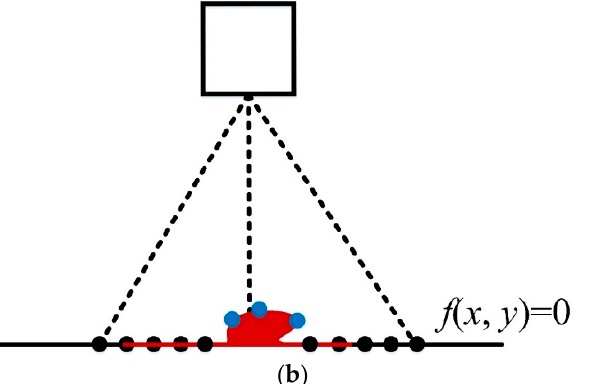
Figure 6. Automatic burr detection. ( a ) contour fitting of processed edge. ( b ) contour fitting of parting lines/risers.